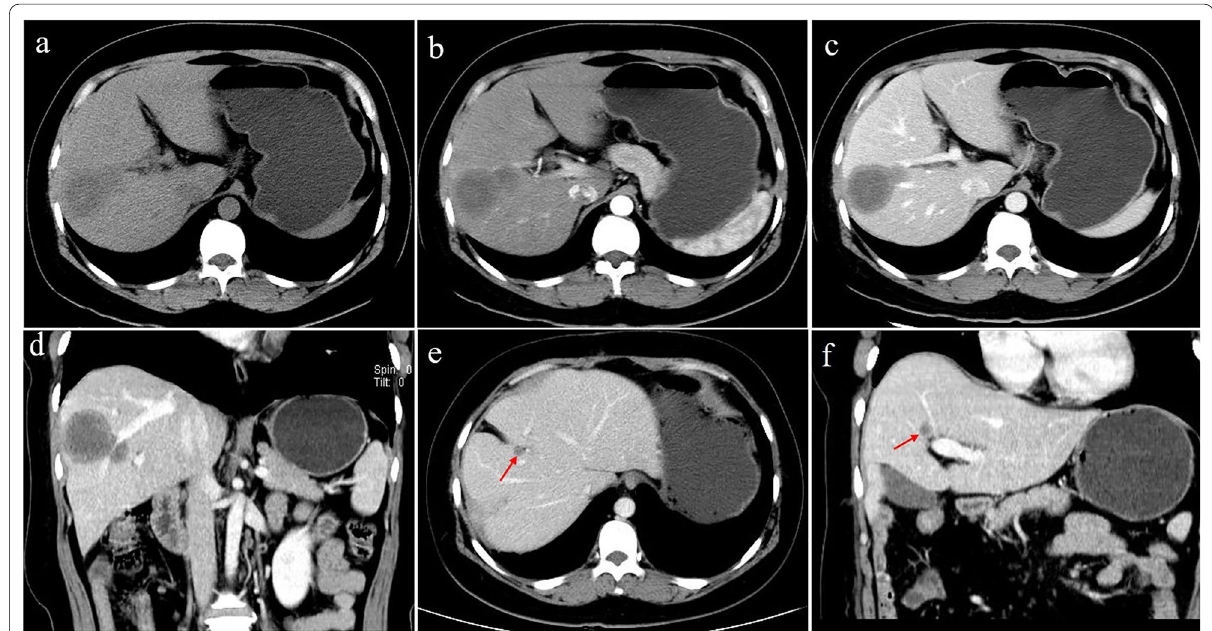
Fig. 2 A 41-year-old female with solitary nodular type HEH. An axial unenhanced CT image a shows a round nodule with ill-defined, heterogeneous hypodensity. An axial arterial phase image ( b ) shows rink-like enhancement. An axial portal phase image ( c ) shows “target” sign enhancement. Coronal reconstruction of the portal venous phase ( d ) shows a narrowing portal vein branch adjacent to the lesion. This patient was initially misdiagnosed with hepatic abscesses. On follow-up CT performed 10 months after resection ( e , f ), a new lesion was detected in the right lobe of the liver (red